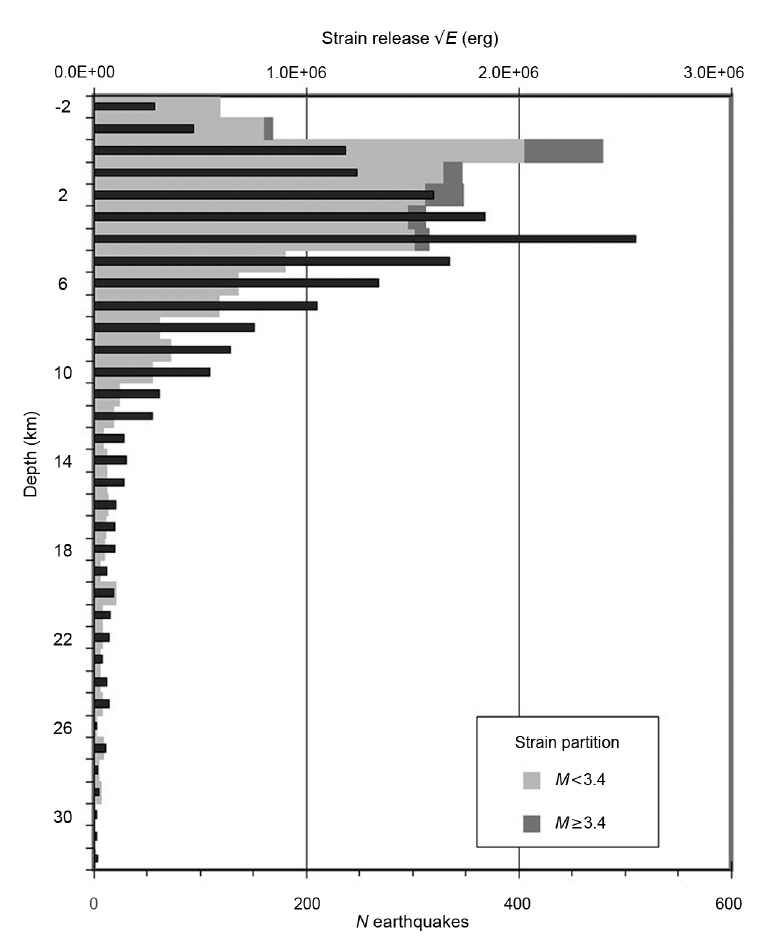
Fig. 3. Distribution of strain release versus depth (km below sea level) on Etna’s eastern flank obtained from instrumental data (1999-2005, from Gruppo di Lavoro Analisi Dati Sismici, 2005).